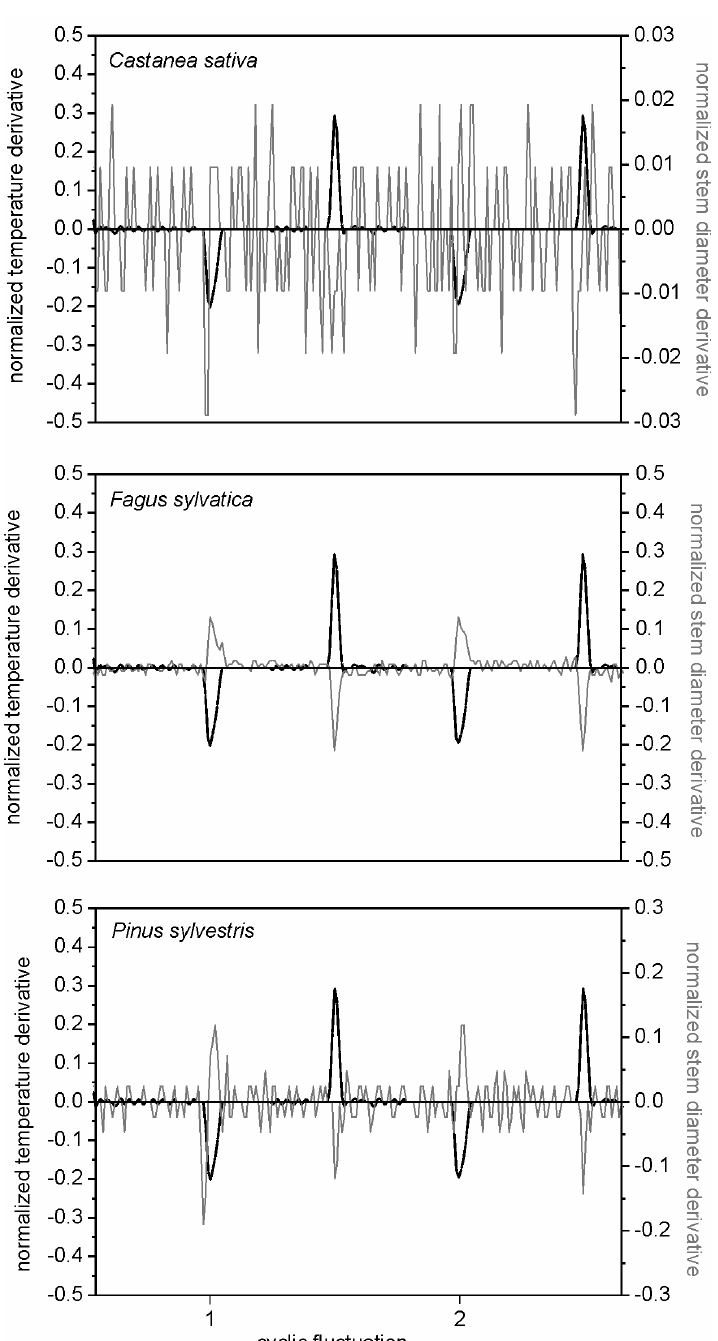
Figure 6. Normalized derivative of temperature (black line) and stem diameter (grey line) of C. sativa, F. sylvatica and P. sylvestris logs exposed to cooling test, showing detail of two repeated cooling